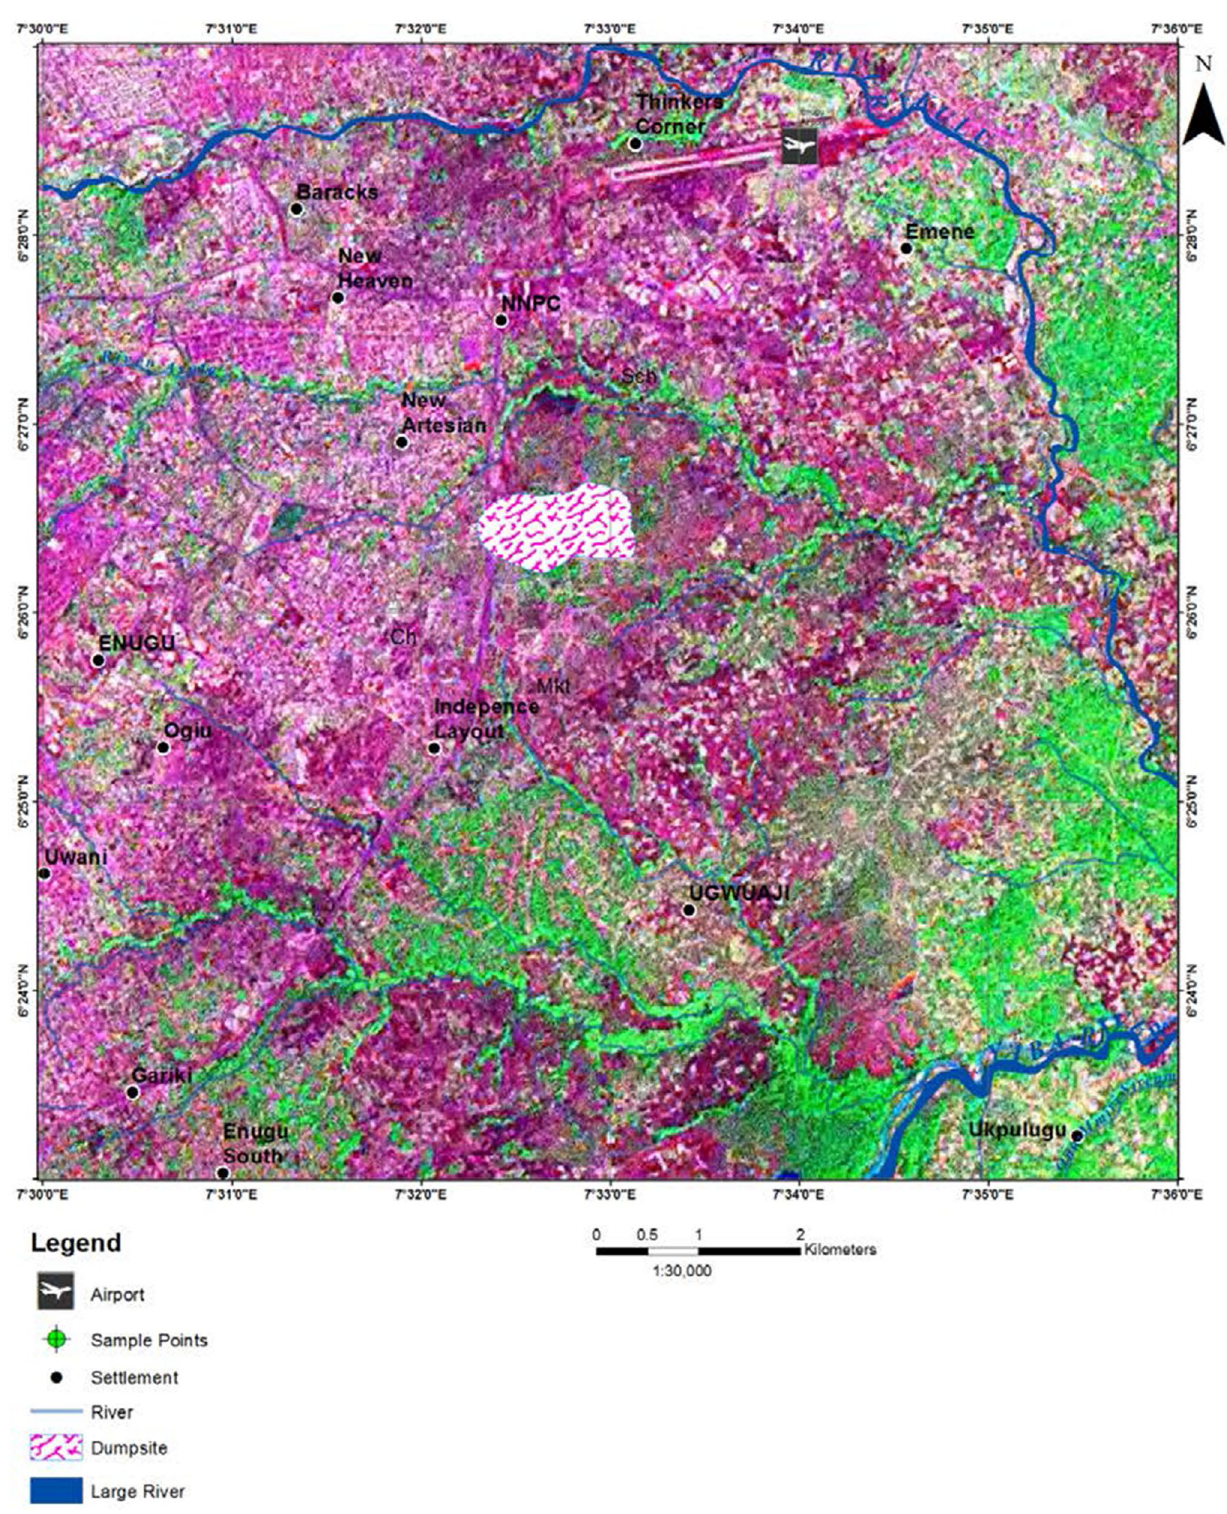
Fig. 4 Landsat imagery of the study area showing dumpsite